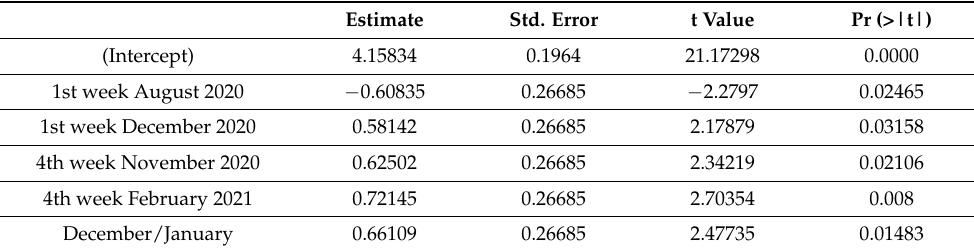
Table 6. Significant variable estimates for TSP.